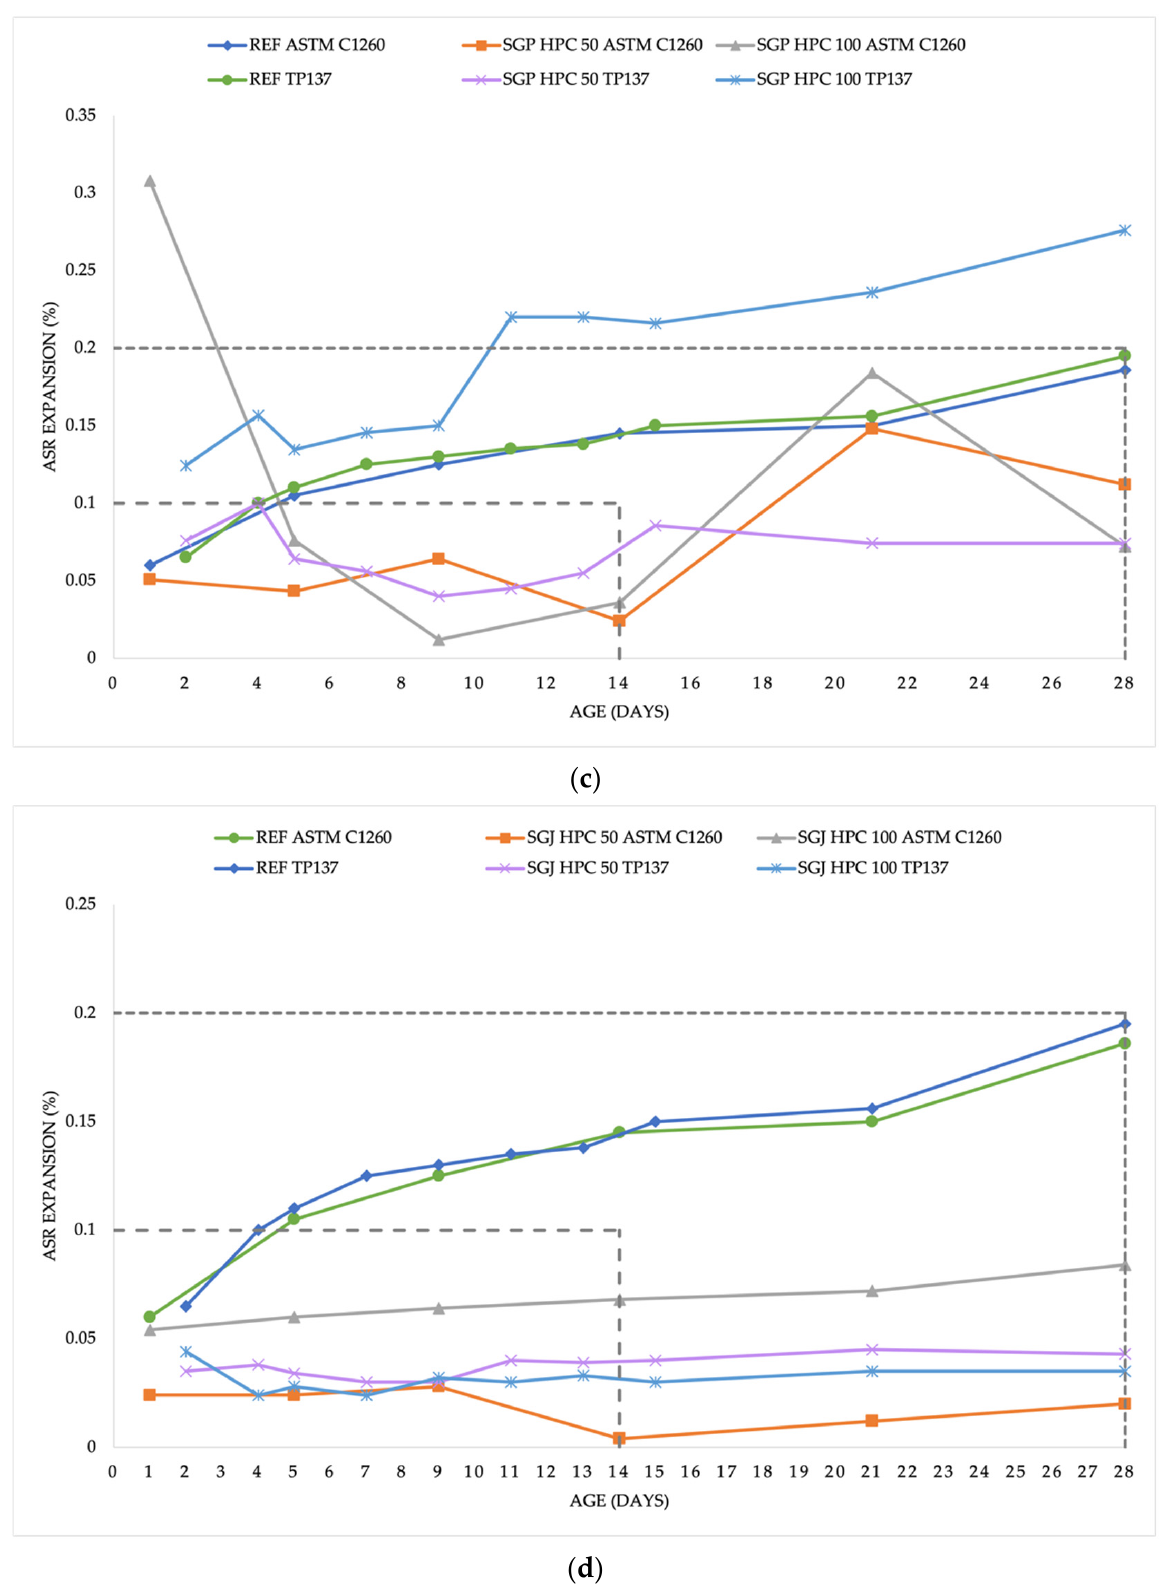
Figure 2. Dependence of the alkali ‐ silica reaction process on time according to ASTMC1260 and TP137: ( a ) CWG HPC; ( b ) GPP HPC; ( c ) SGP HPC; ( d ) SGJ HPC.